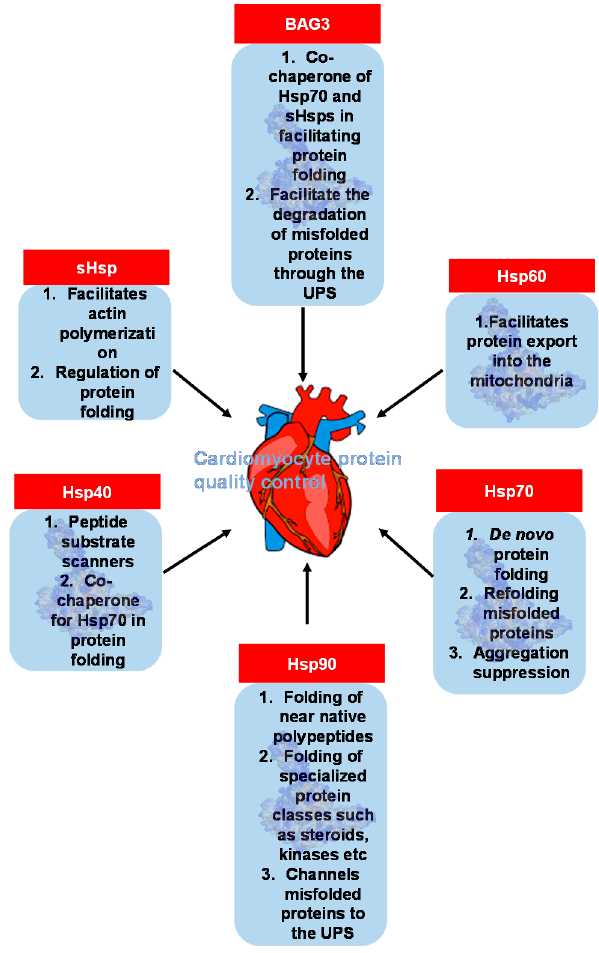
Figure 5. Functions of molecular chaperones in regulating cardiomyocyte protein quality. The major molecular chaperone families and their roles in the maintenance of cardiomyocyte protein quality control are illustrated. Hsp70, Hsp90, sHsp and Hsp40 are particularly important in pro- tein folding, while Hsp60 facilitates protein translocation and BAG3 facilitates the degradation of misfolded proteins.